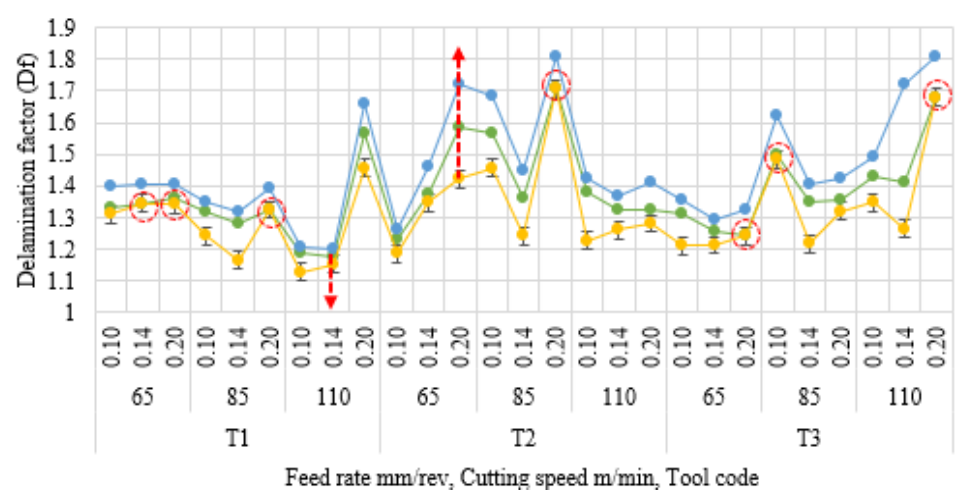
Figure 7. Conventional, adjusted, and minimum delamination factor values based on drilling parameters and coating properties